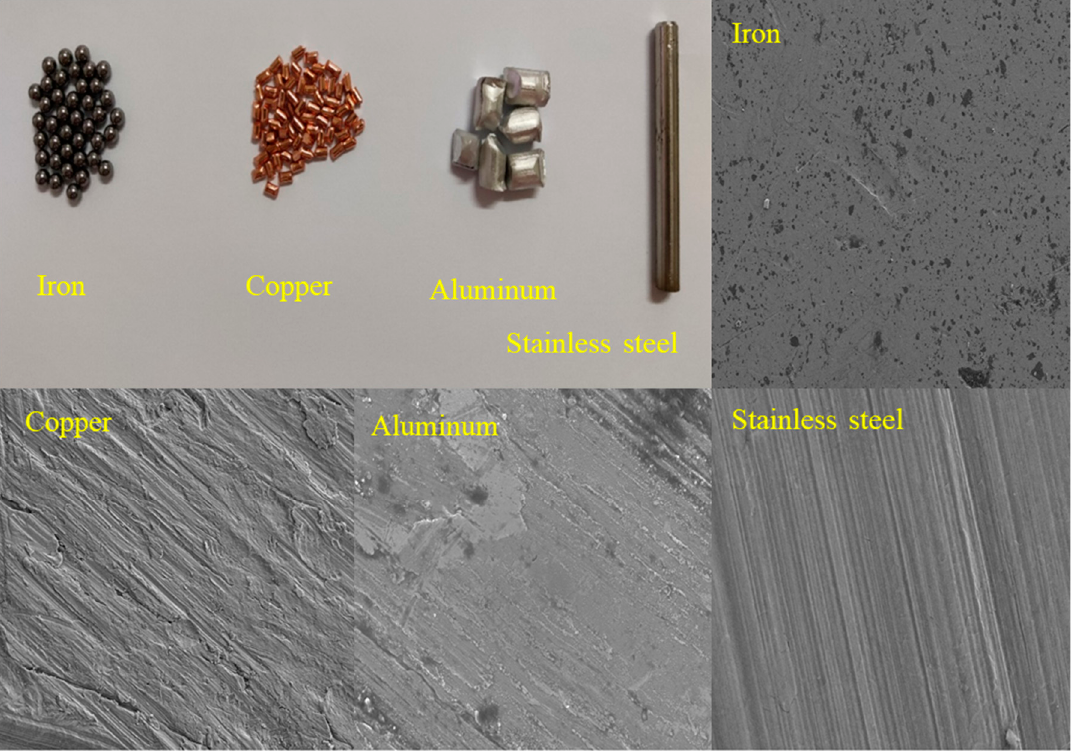
Figure 13. Surface colors and SEM images of four metals.